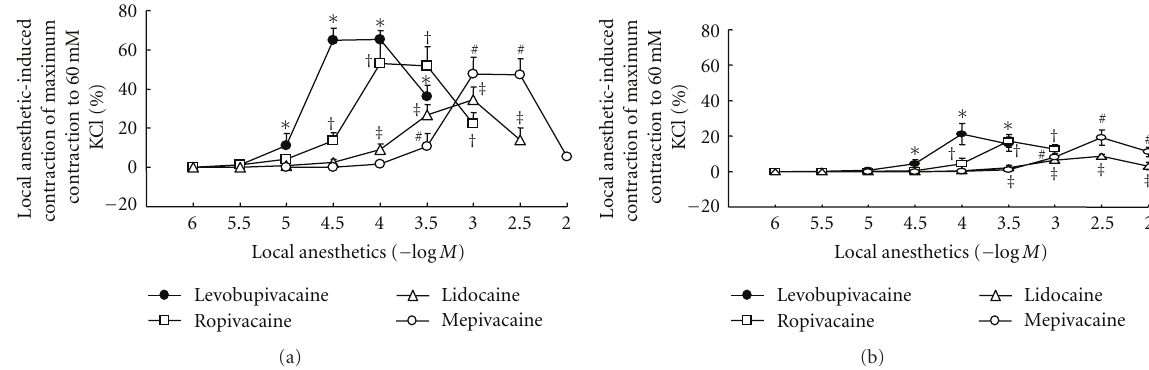
Figure 1: Concentration-response curves induced by levobupivacaine, ropivacaine, lidocaine, and mepivacaine in isolated endothelium- denuded (a) and -intact (b) aorta. All values are shown as mean ± SD and expressed as the percentage of the maximal contraction induced by 60mM KCl. N indicates the number of rats from which descending thoracic aortic rings were derived. (a) Isotonic 60 mM KCl-induced con- traction in endothelium-denuded aorta: 100% = 2.94 ± 0.66 g ( n = 6) with levobupivacaine, 100% = 3.24 ± 0.51 g ( n = 6) with ropivacaine, 100% = 2.88 ± 0.49 g ( n = 6) with lidocaine, and 100% = 2.91 ± 0.36 g ( n = 6) with mepivacaine. ∗ P < 0 . 01 versus 10 − 6 M levobupivacaine; † P < 0 . 01 versus 10 − 6 M ropivacaine; ‡ P < 0 . 01 versus 10 − 6 M lidocaine; # P < 0 . 01 versus 10 − 5 M mepivacaine. (b) Isotonic 60 mM KCl- induced contraction in endothelium-intact aorta: 100% = 2.42 ± 0.50 g ( n = 6) with levobupivacaine, 100% = 2.44 ± 0.43 g ( n = 6) with ropivacaine, 100% = 2.11 ± 0.56 g ( n = 6) with lidocaine, and 100% = 2.43 ± 0.28 g ( n = 6) with mepivacaine. ∗ P < 0 . 001 versus 10 − 6 M